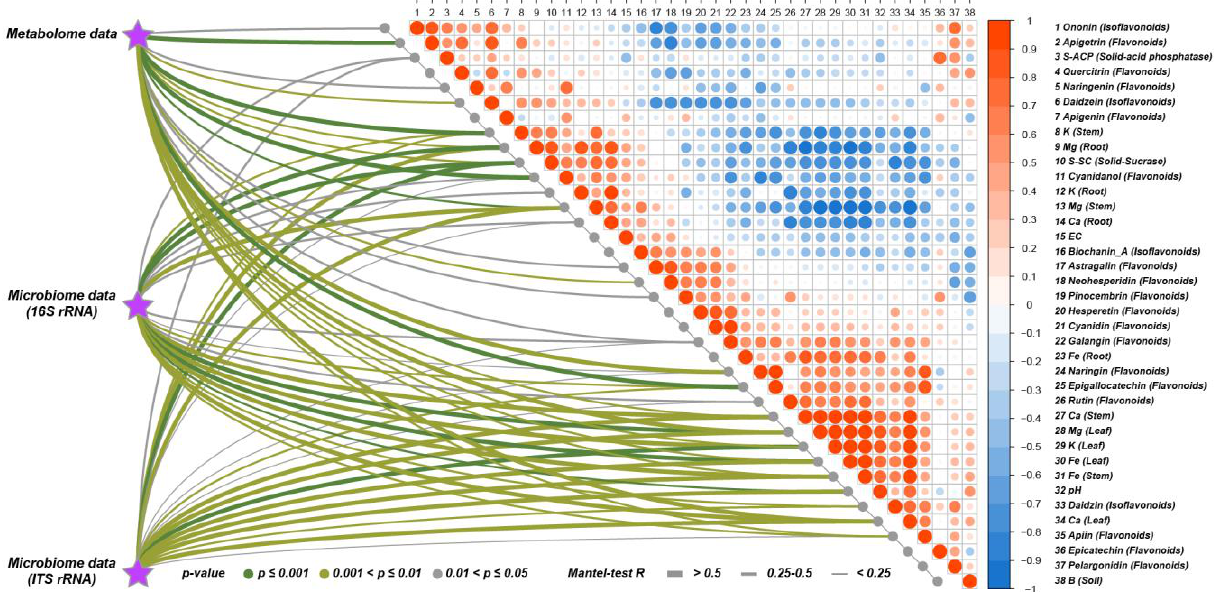
Figure 11. Correlation analysis of soil and plant chemical properties and root metabolome. The color gradient on the right represents Spearman’s correlation coefficients. The chemical properties and metabolites used have passed the partial Mantel tests. The thickness of the curve in the figure is proportional to the Mantel r statistic of the corresponding distance correlation, and the color of the curve indicates the statistical significance based on 9999 permutations (the legend at the bottom corresponds to p values).